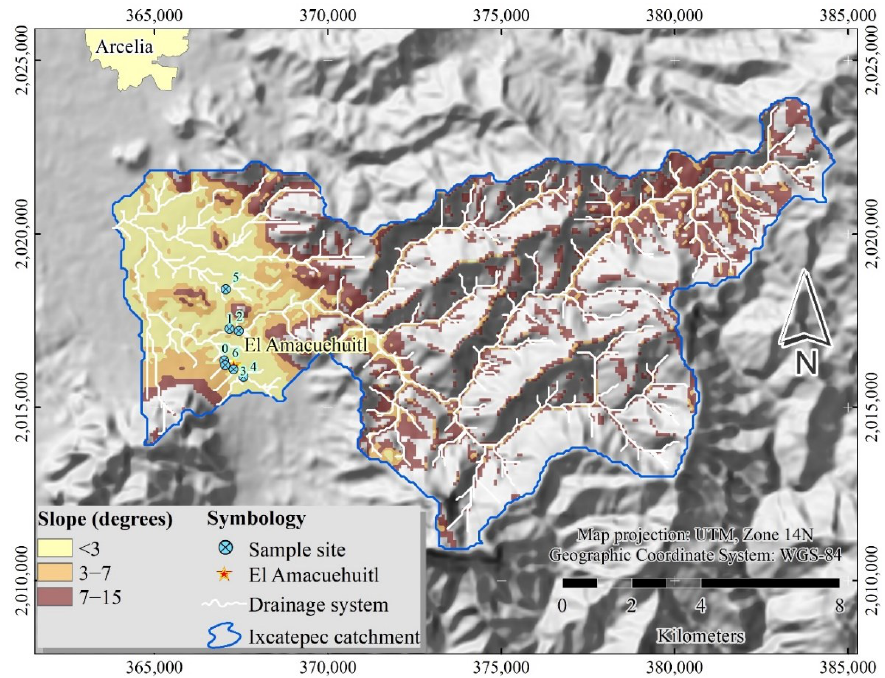
Figure 5. Map of the slope less than 15° into the Ixcatepec catchment (47.4% of the total catchment). Sample sites: Wells (Drinking water, 0; Brocal, 3; El Azul, 4; Tello, 6); Stream water (Ixcatepec river and Arroyo, 1 and 2); pond (El Ushe, 5).